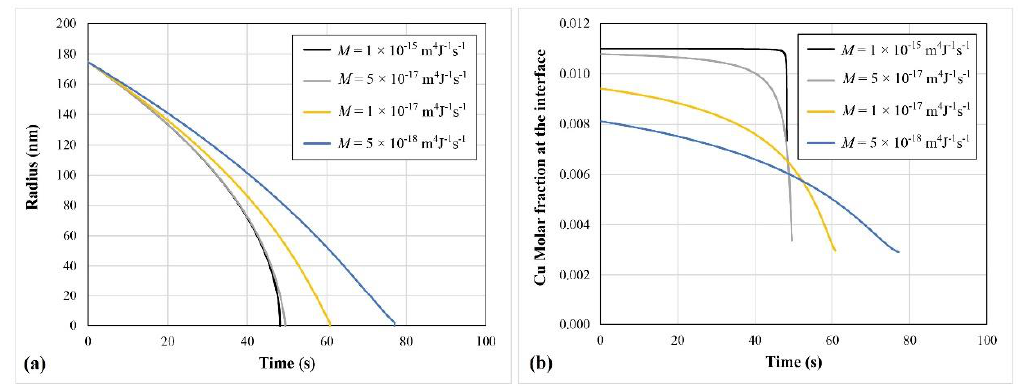
Figure 3. Evolutions of ( a ) the radius and ( b ) the Cu molar fraction at the interface of a spherical θ -Al 2 Cu precipitate dissolving in an infinite matrix with different values of the interfacial mobility.